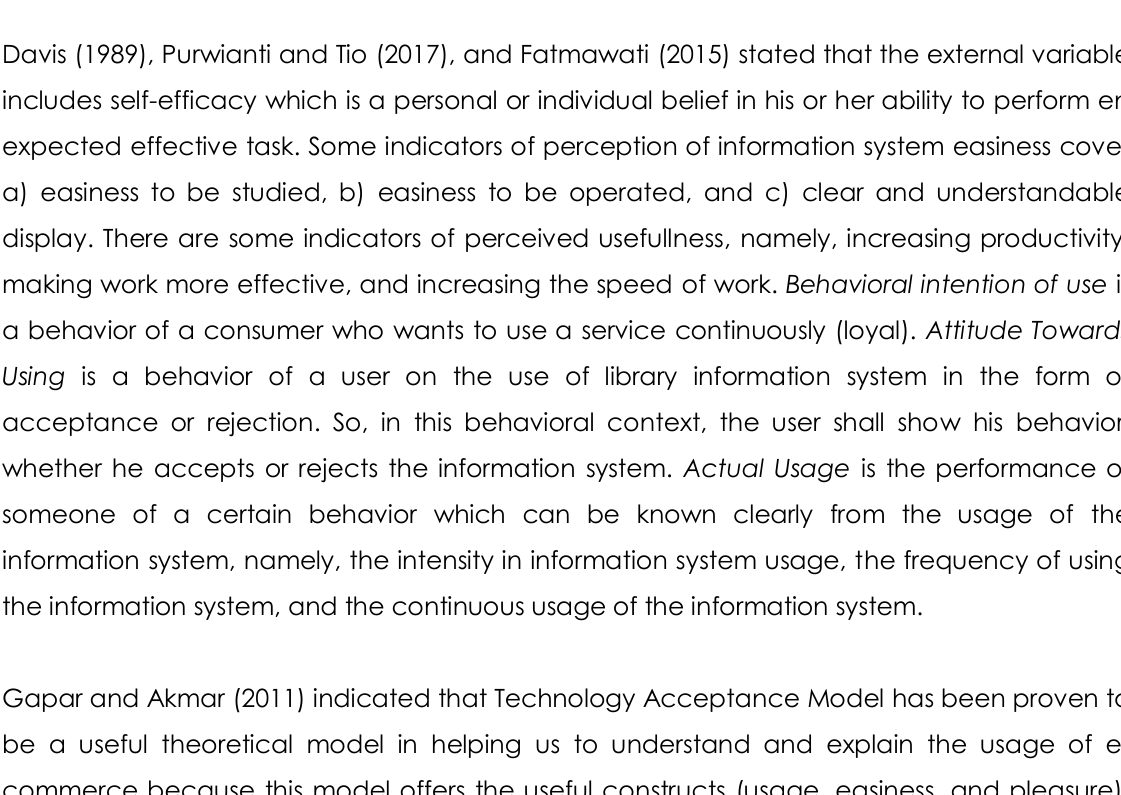
Figure 1. Model Basic Technology Acceptance Model